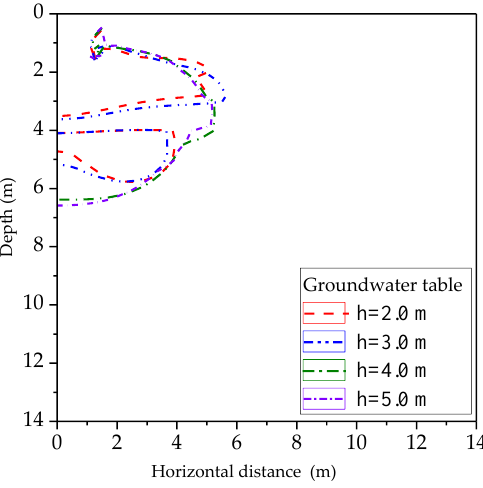
Figure 20. Cloud lines of I r = 7.7% in grounds with different levels of groundwater. Figure 21 shows comparisons of excess pore pressure ratios in the embedded weak layer in grounds with different levels of groundwater after DC. It is found that when the level of groundwater was above the weak layer, the excess pore pressure in the embedded weak layer increased significantly, and this influence decreased as the groundwater table